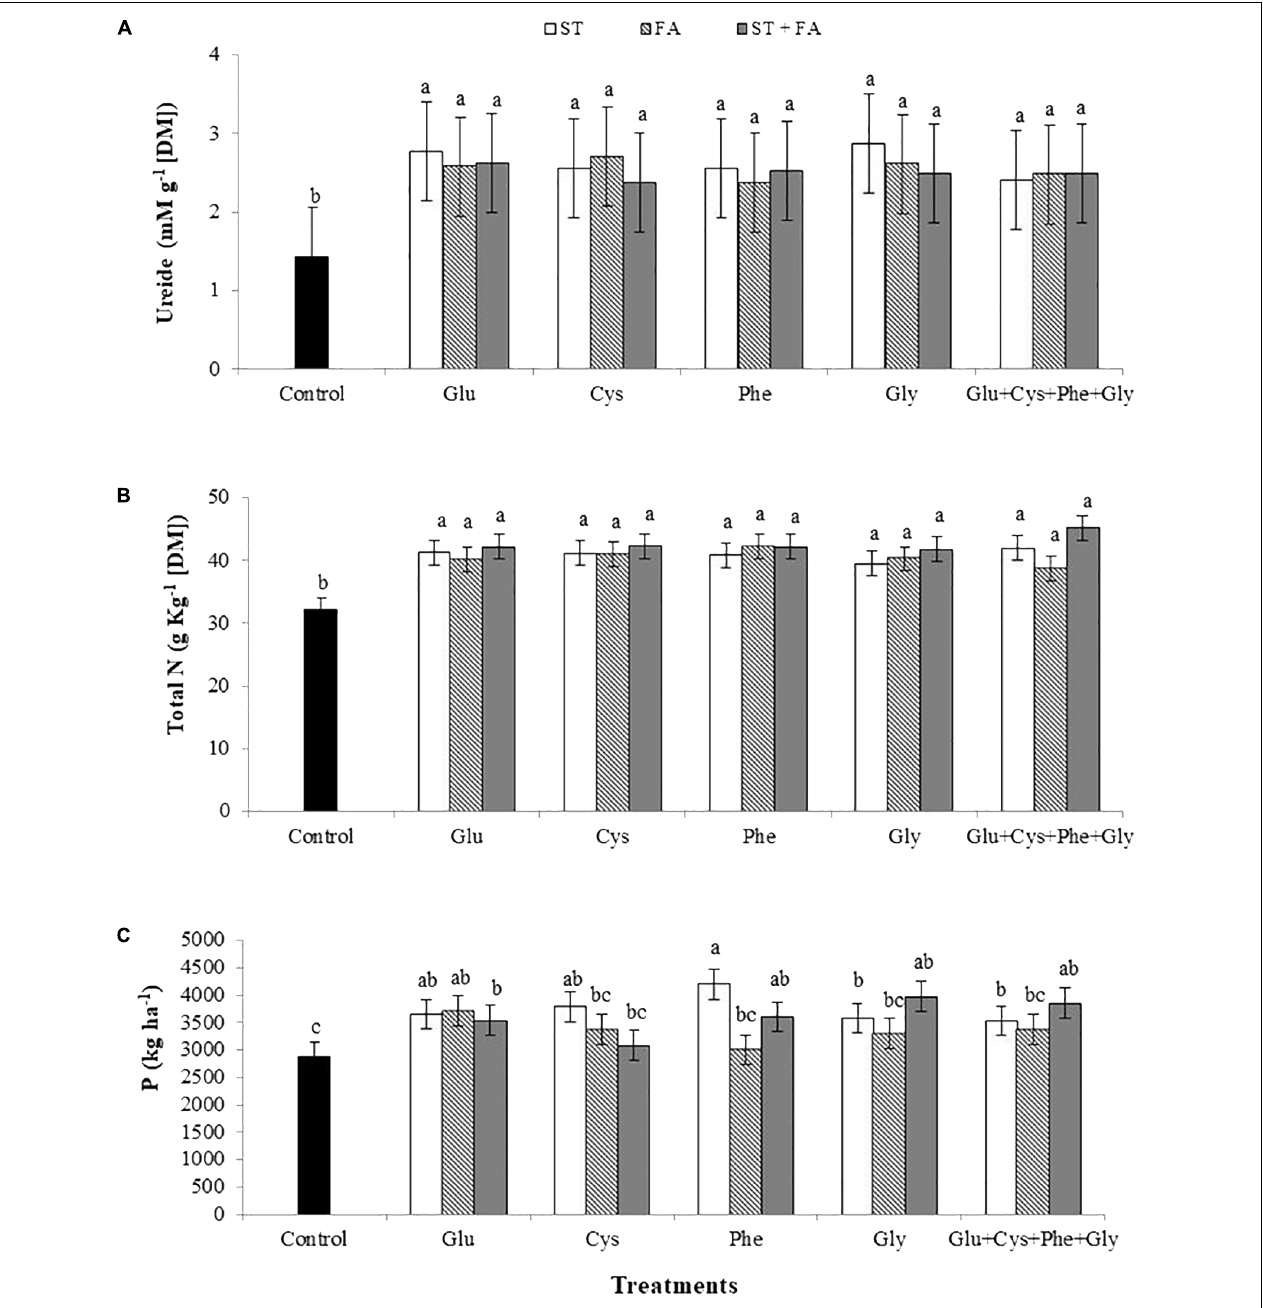
FIGURE 4 | Effects of use of glutamate (Glu), cysteine (Cys), phenylalanine (Phe), glycine (Gly) and all these amino acids in association (Glu+Cys+Phe+Gly), as a function of seed treatment (ST) and/or foliar application (FA), on the ureide (A) , total nitrogen (Total N, B ) at V 6 stage and productivity (P, C ). Field experiment. Season 2014/2015. Means followed by the same letters do not differ significantly from each other, using the Duncan test at 5%